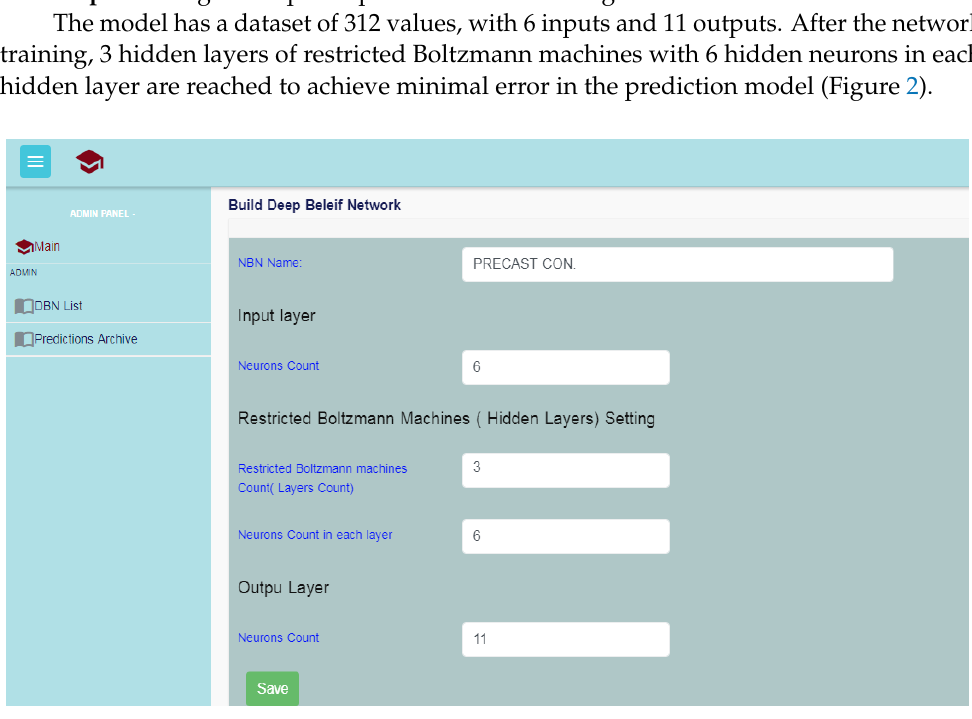
Figure 3. Setting the required parameters for the training operation code.